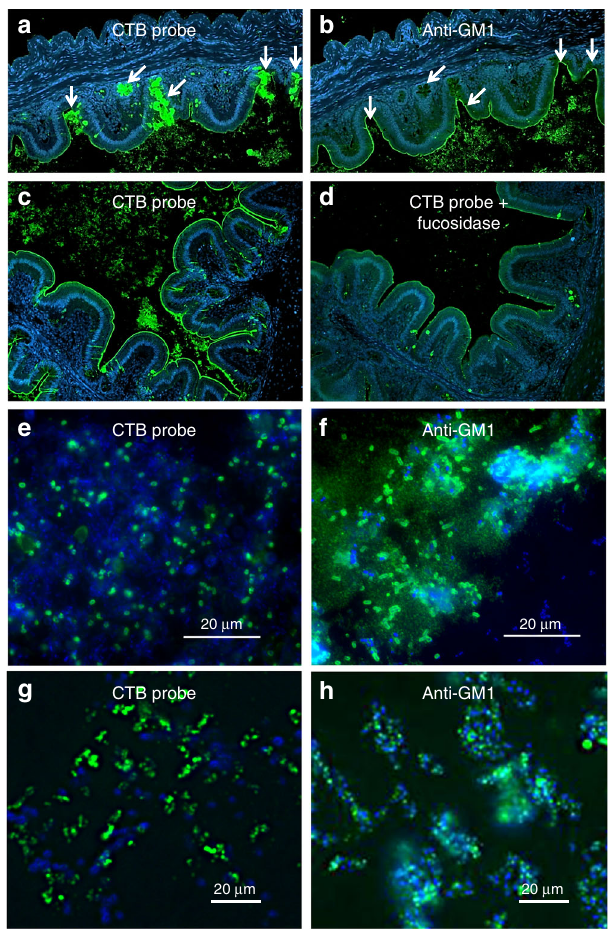
Fig. 6 Cholera toxin (CT) binds to goblet cells, mucins and commensal bacteria in the chicken cecum. Fluorescence microscopy of sequentially cut chicken cecal cross-sections labeled with DAPI (blue) and either α -CT (green) ( a , c – e , g ) or α -GM1 ganglioside (green) ( b , f , h ). Images a – d were taken at ×200. Arrows in a , b indicate goblet cells and mucus. d Cells were treated with fucosidase prior to labeling. e , f Magni fi ed images to show bacterial binding. g CTB (green) and DAPI (blue) labeling of bacteria isolated after CTB-protein G pulldown of bacteria isolated from the initial GM1-protein G pull-down h Bacteria isolated after GM1 pulldown and labeled with DAPI (blue) and α